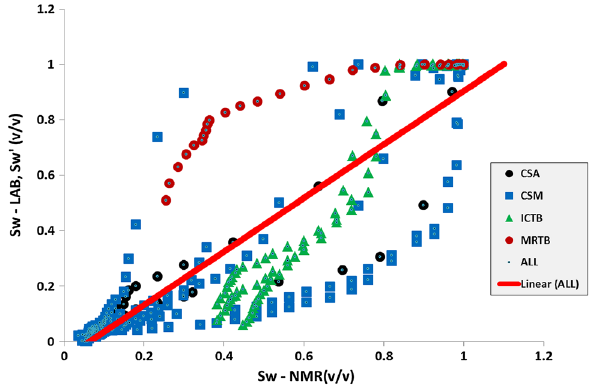
Fig. 22 Plot of S S w-LAB versus w-NMR for all samples within the vari- ous genetic reservoir units. The red thick line indicates a possible averaging with various scaling factors for each